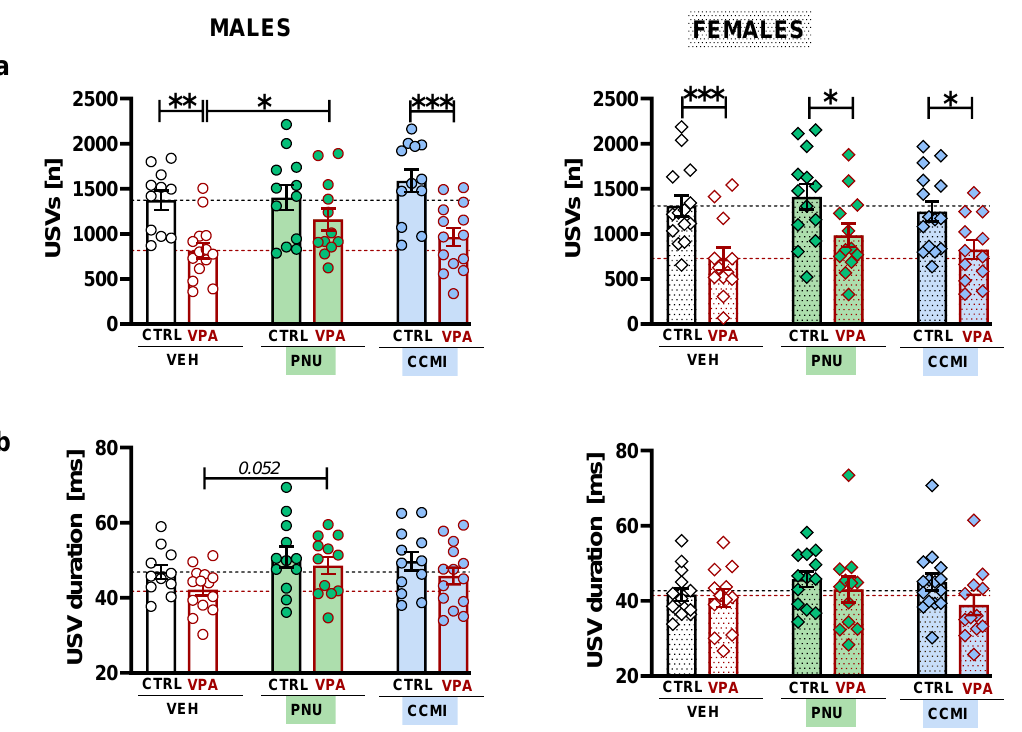
Figure 2. The effect of α 7–nAChR PAMs on USV emission in VPA and CTRL male and female rats. Data are presented as a mean ± SEM of the number of 50-kHz USVs ( a ) and the average durations of the emitted calls ( b ). The tested compounds (or vehicle, VEH) were administered at a dose of 1 mg/kg 30 min prior to testing. Symbols: *** p < 0.001, ** p < 0.01, * p < 0.05, planned comparisons.